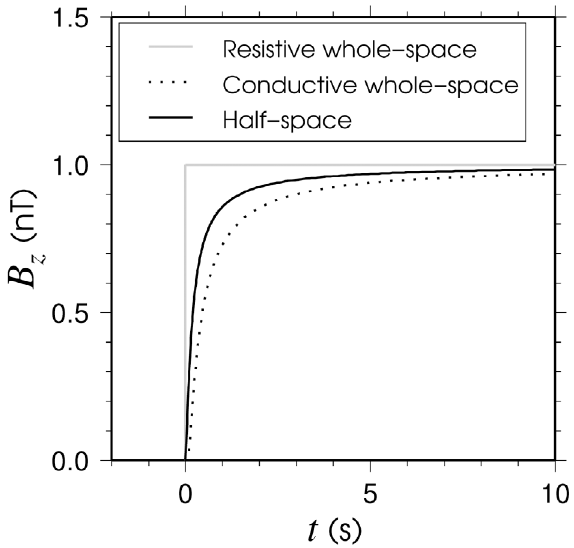
Figure 8. A comparison of the temporal variation in the vertical component of the magnetic field for the source-receiver geometry shown in Figure 4b for whole-space (solid black line) and two-layer (dotted line) models. For reference, the solution for a resistive whole-space (i.e., a vacuum) is also